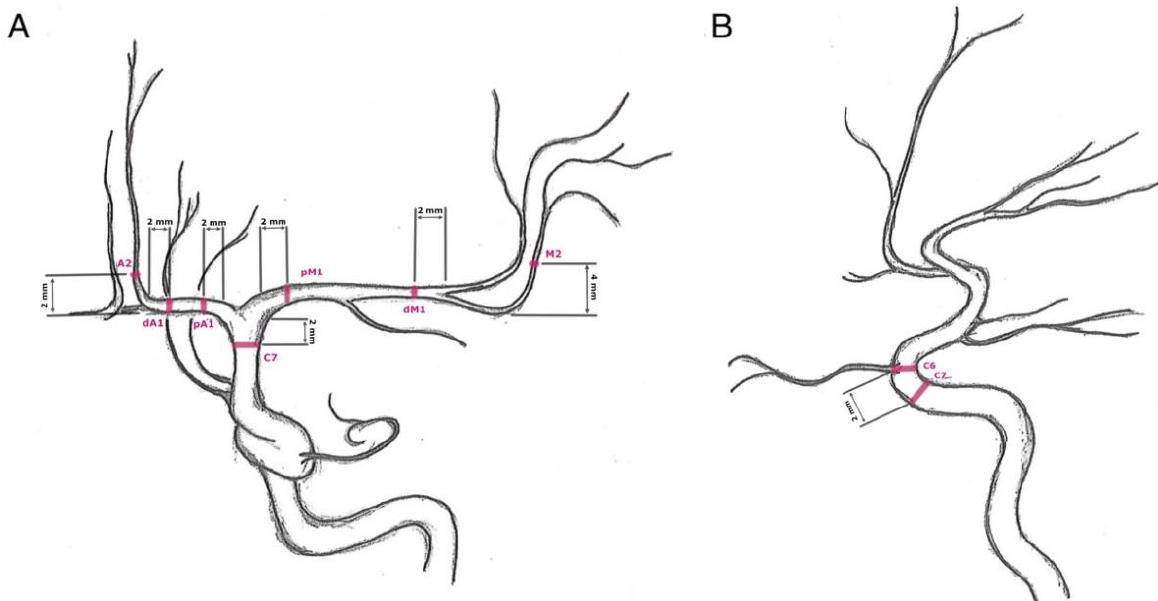
Figure 1. Measuring sites: ( A ) posterior – anterior projection of an internal carotid artery angiogram — C7 (terminal segment of the internal carotid artery): 2 mm proximal to the carotid T, pM1 (proximal horizontal segment of the middle cerebral artery): 2 mm distal to carotid T, dM1 (distal horizontal segment of the middle cerebral artery): 2 mm proximal to middle cerebral artery bifurcation, M2 (insular segment of the middle cerebral artery): 4 mm distal to the M1/M2 transition, pA1 (proximal precommunication segment of the anterior cerebral artery): 2 mm distal to carotid T, dA1 (distal precommunication segment of the anterior cerebral artery): 2 mm proximal to change of course, and A2 (postcommunicating segment of the anterior cerebral artery): 2 mm distal to change of course; ( B ) lateral projection of an internal carotid artery angiogram — C5 (clinoid segment of the internal carotid artery): 2 mm proximal to the origin of the ophthalmic artery and C6 (ophthalmic segment of the internal carotid artery): at the origin of the ophthalmic artery.